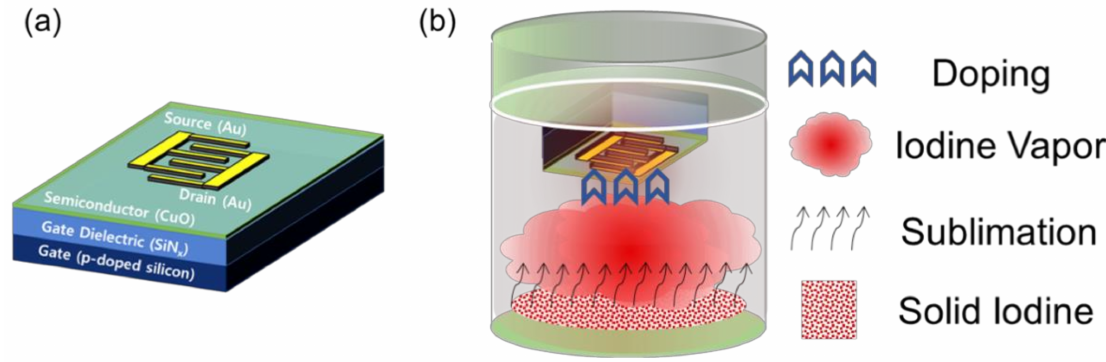
Figure 1. Schematic representations of ( a ) the fabricated CuO TFT and ( b ) the iodine-doping